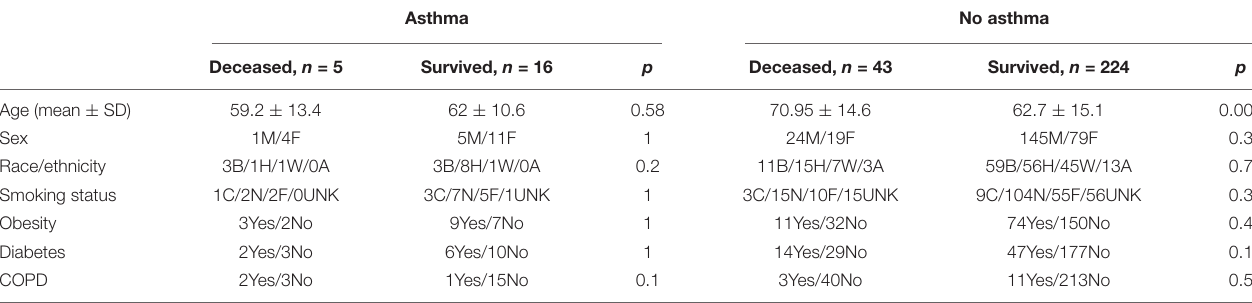
TABLE 1 | Demographics of hospitalized COVID-19 patients.